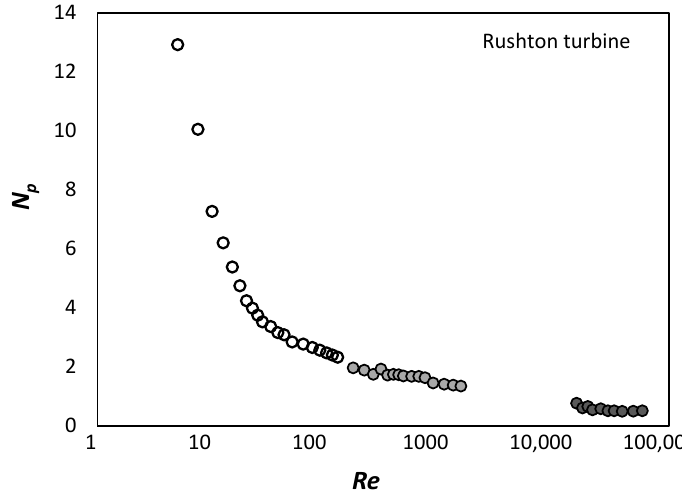
Figure 13. The power number N p evaluated from experimental measurements as a function of the Reynolds number for the Rushton turbine.